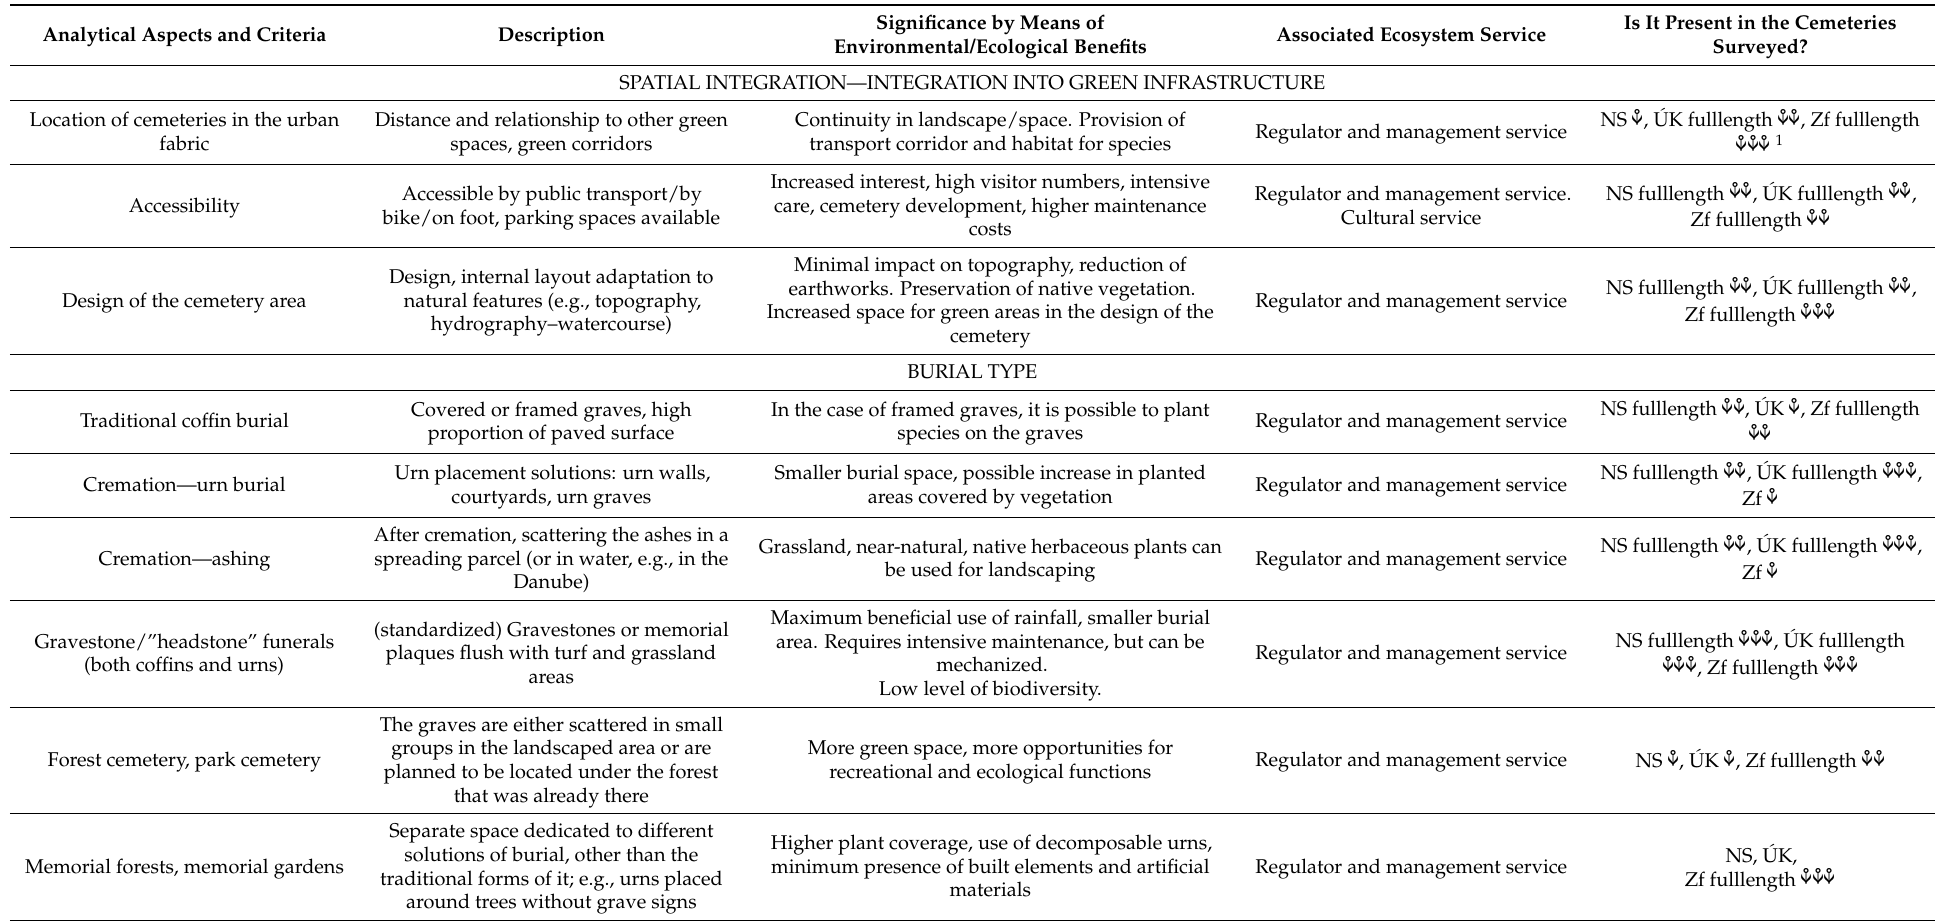
Table 2. Environmental (habitat) values of cemeteries (authors’ table).